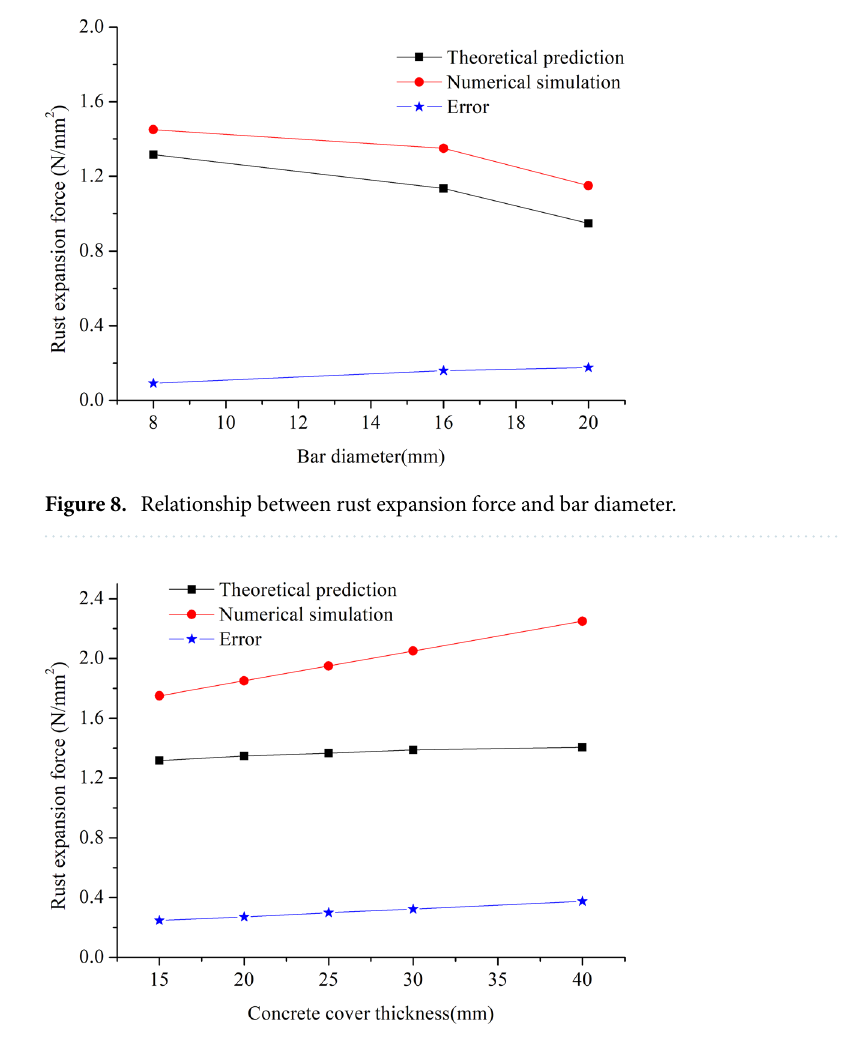
Figure 9. Relationship between rust expansion force and concrete cover